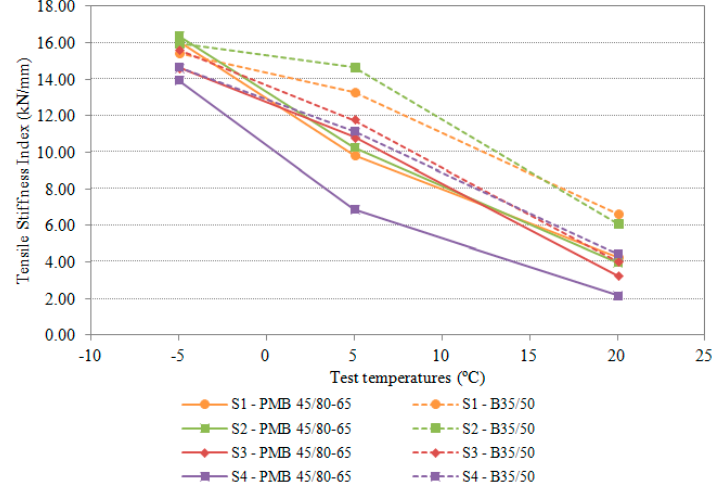
Figure 10. Tensile stiffness index versus temperature.